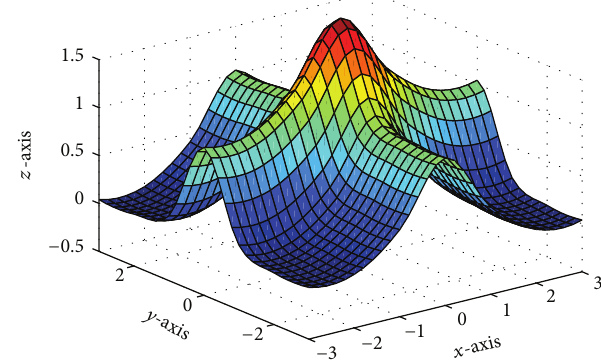
Figure 10: Bicubic Hermite